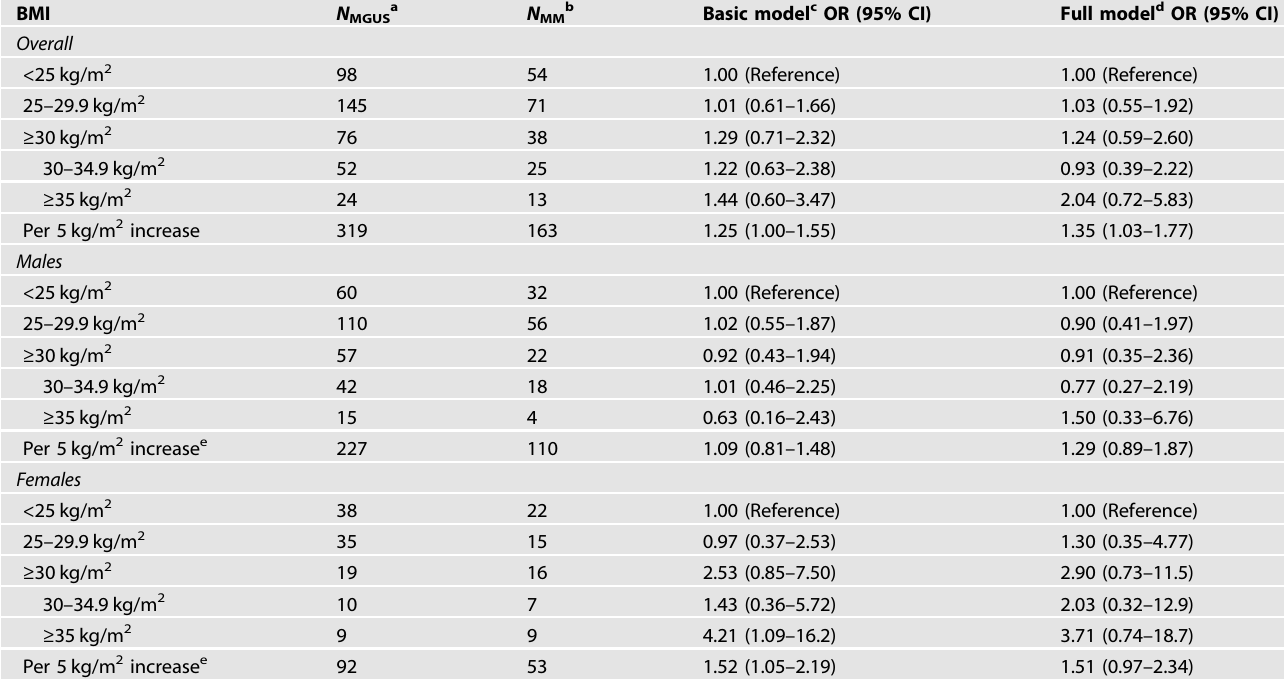
Table 1. Associations between BMI and risk of progression from non-IgM MGUS to MM, overall and strati fi ed by